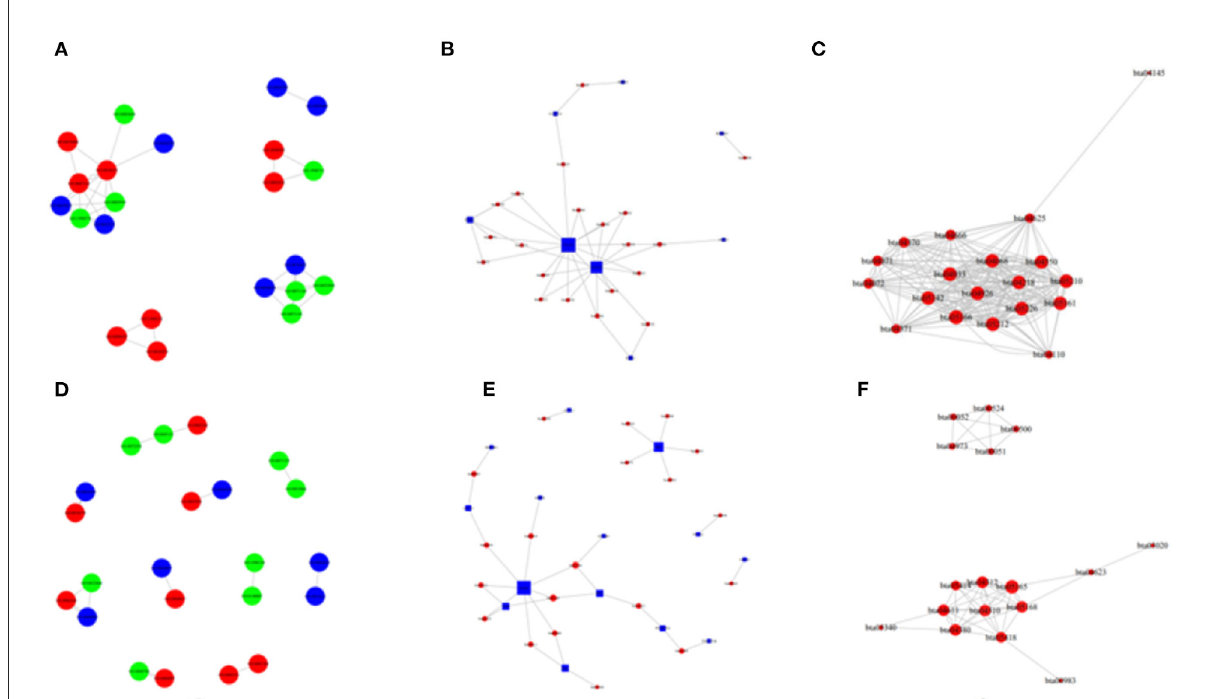
FIGURE10 The network of GO enriched terms and pathways in the H vs. P and M vs. P groups. (A) The GO to GO network of u p- regulated terms in cattle between the comparison of cattle and cattle-yak. (B) The pathway enrichment top network between the comparison of cattle and yak. (C) The pathway to pathway top network between of u p- regulated in cattle between he comparison of cattle and cattle-yak. (D) The GO to GO network of u p- regulated terms in yak between the comparison of yak and cattle-yak. (E) The pathway enrichment top network between the comparison of yak and cattle-yak. (F) The pathway to pathway top network between of u p- regulated in yak between he comparison of yak and